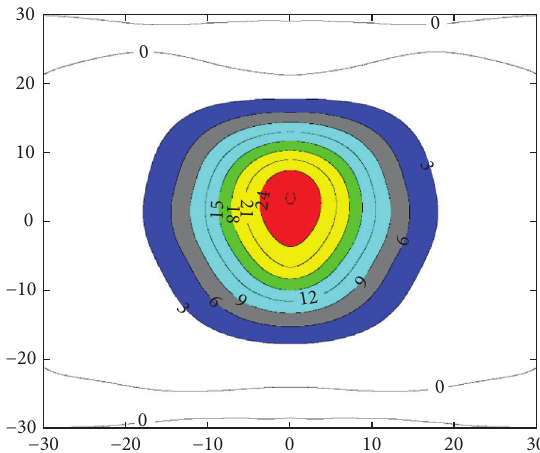
Figure 21: Contour figure of ground frost heave caused by freezing for 90 days (mm. 0 537 α � 10 ° ).